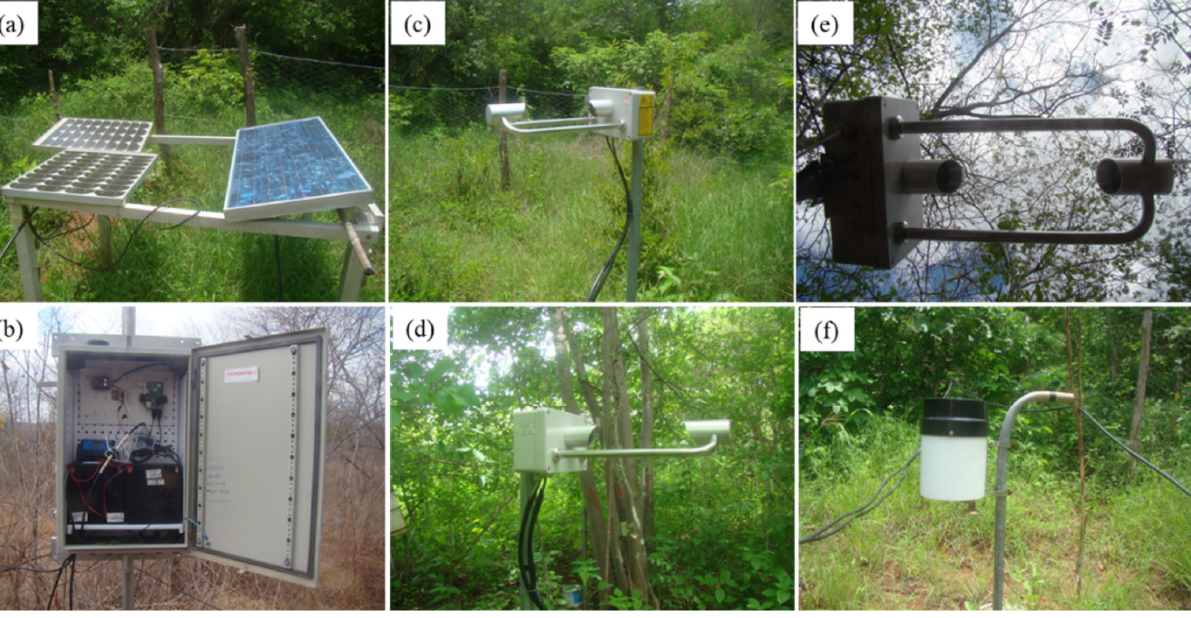
Figure 2. Experimental setup: ( a ) solar panel, ( b ) box with batteries, converters and Raspberry, ( c ) open field disdrometer, ( d , e ) disdrometer under TDF canopy, and ( f ) tipping-bucket rain